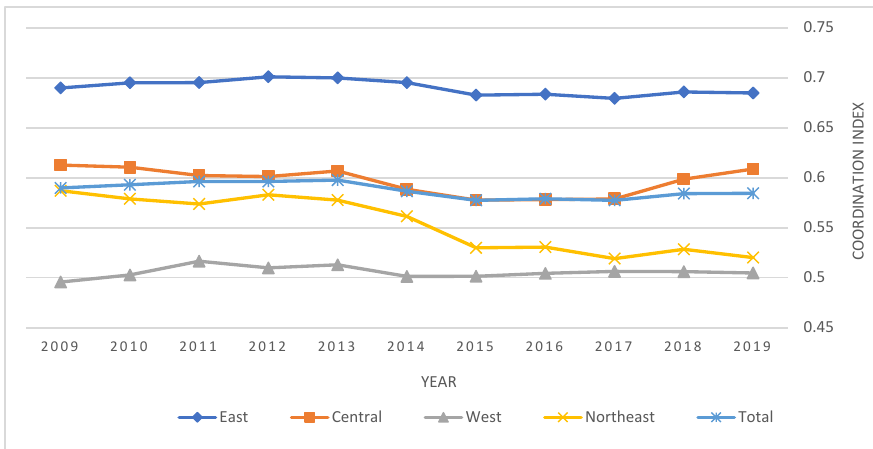
Figure 5. Coordination development level of the aging industry and regional economy. From the perspective of the sub-regions, as shown in Figure 6, the eastern region had the highest level of coordination, the central region was basically close to the average, and slightly exceeded the average in the last two years. The western region had the lowest level of coordinated development with little improvement, while the coordination status of the northeast region dropped from close to the average in 2009 and approached the level of the western region in 2019. If this tendency continues, the northeast region may become the region with the worst level of coordination.